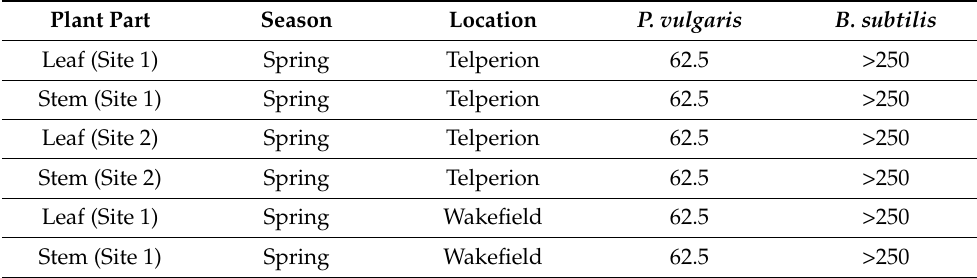
Table 1. Antibacterial activity of the hydroalcoholic extracts from leaves and stems of H. aureonitens , with the MIC values ( µ g/mL) obtained from different sites at two different climatic locations and in two different seasons of the year against the Gram-negative bacterium P. vulgaris and the Gram- positive bacterium B. subtilis